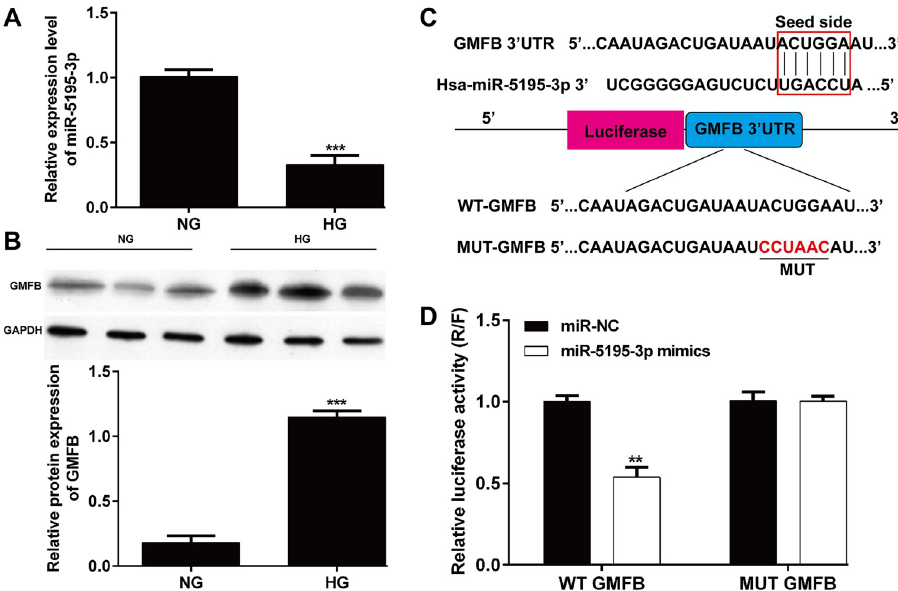
Fig 1. The expression levels and correlation of miR-5195-3p and GMFB. (A) In HG-induced ARPE-19 cells, miR- 5195-3p was significantly downregulated compared with that of NG group. (B) GMFB protein expression was upregulated in HG-induced ARPE-19 cells compared with that of NG group. ��� p < 0.001, compared with NG; (C) miR-5195-3p was predicted as a direct target of miR-5195-3p predicted by the miRNA online database (TargetScanHuman7.1). (D) Dual-luciferase reporter assay using ARPE-19 cells showed the direct interaction of miR- 5195-3p and the 3 0 UTR of GMFB. After 48-h co-transfection, overexpression of miR-5195-3p reduced the luciferase activity of WT reporter but had no inhibition on the MUT reporter. Data were shown as mean ± SD. �� p < 0.01 compared with miR-NC. NC, negative control; HG, high glucose; NG, normal glucose; WT, wild type; MUT, mutant